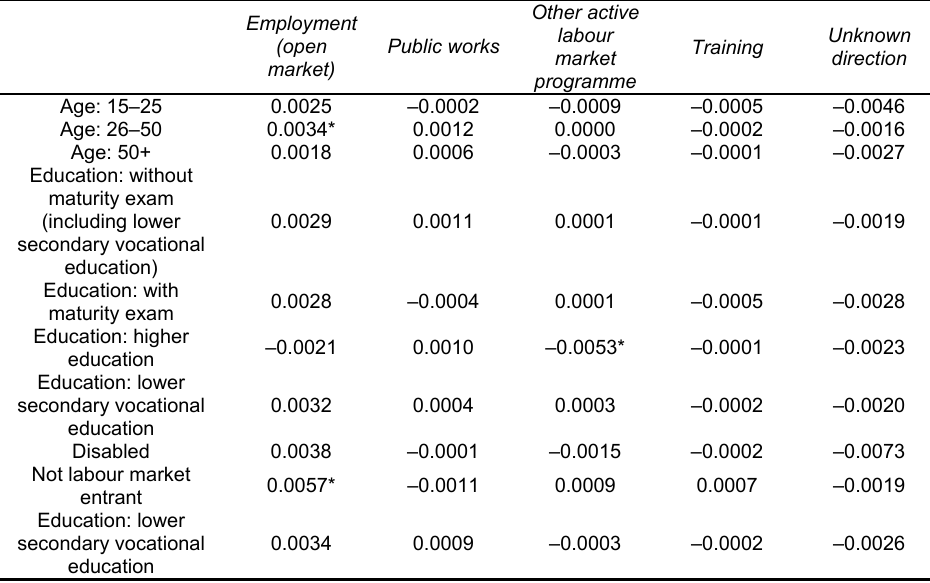
Table 6: Programme effects for different subgroups of registered unemployed and for different exit